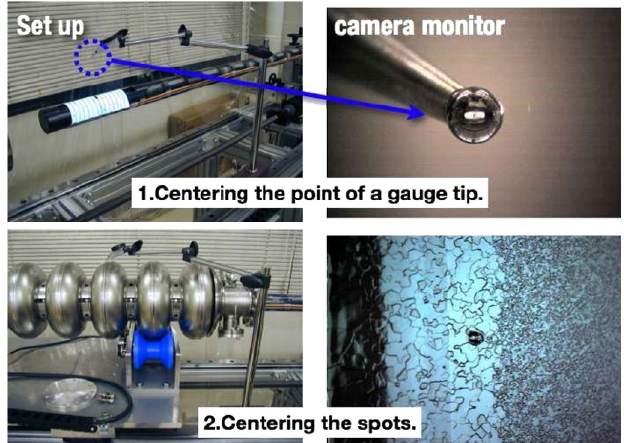
FIG. 10. (Color) Schematic drawing of the wall gradient mea- surement. The wall gradient, the incident angle and the reflection angle are the same. The value (cid:2) can be calculated from the position z o of the illuminator.